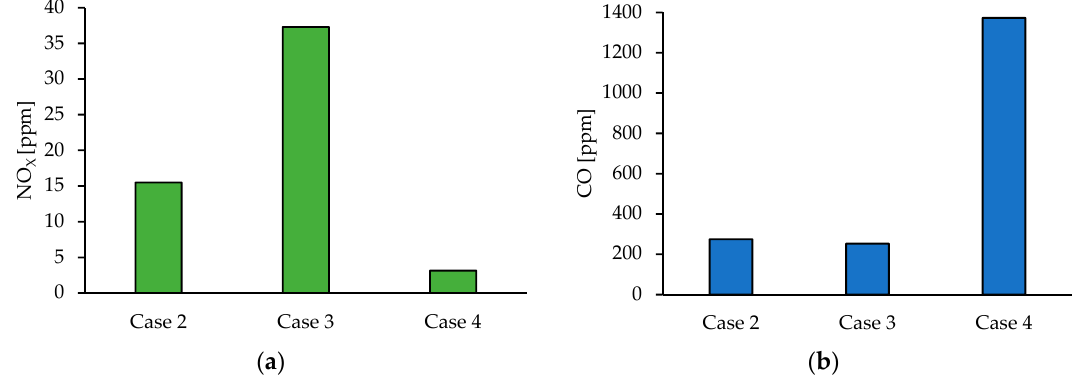
Figure 10. ( a ) NO X and ( b ) CO emissions of Cases 2–4, shown Figure 6.